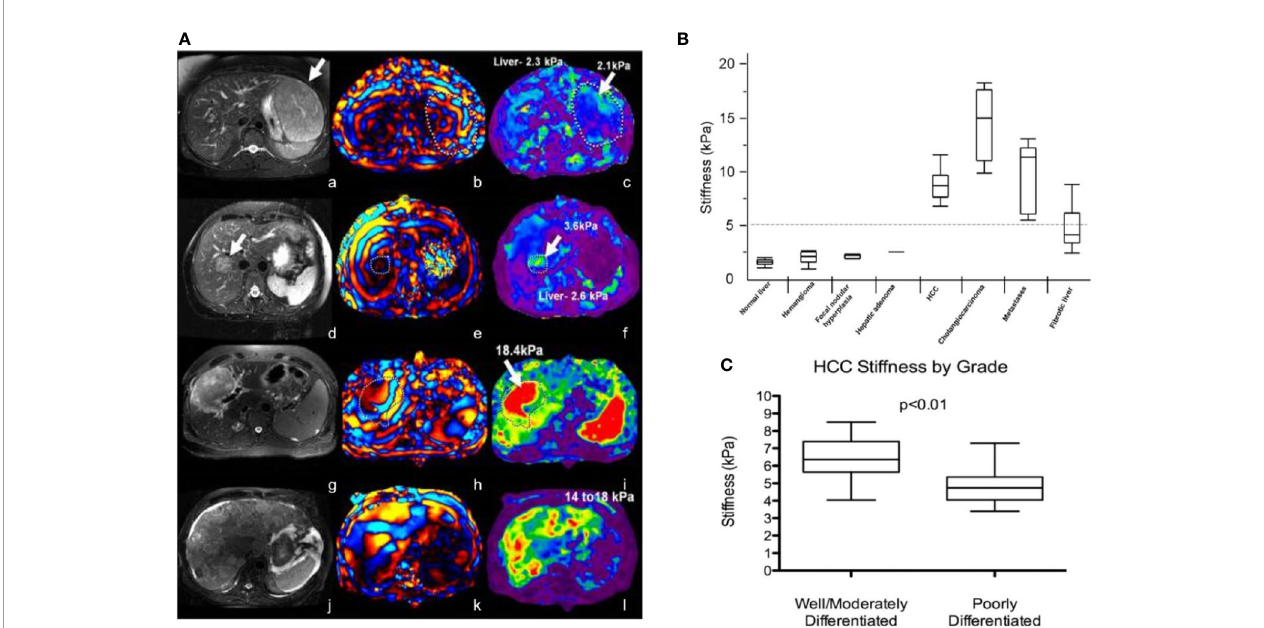
FIGURE 2 | (A) MRE of liver tumors. The stiffness value of benign tumors (focal nodular hyperplasia, a-c; liver adenoma, d-f) is equivalent to that of normal liver parenchyma (generally less than 5 kPa), while the stiffness of malignant tumors (hepatocellular carcinoma-cholangiocarcinoma, g-i; colorectal cancer metastasis, j-l) is increased Reproduced with permission from ref. (46), copyright 2013, John Wiley & Sons Inc. (B) Shear stiffness of different tissues. Reproduced with permission from ref. (45), copyright 2008, American Roentgen Ray Society. (C) Schematic diagram of HCC tumor grade corresponding to tumor stiffness (kPa). Reproduced with permission from ref. 23, copyright 2017,